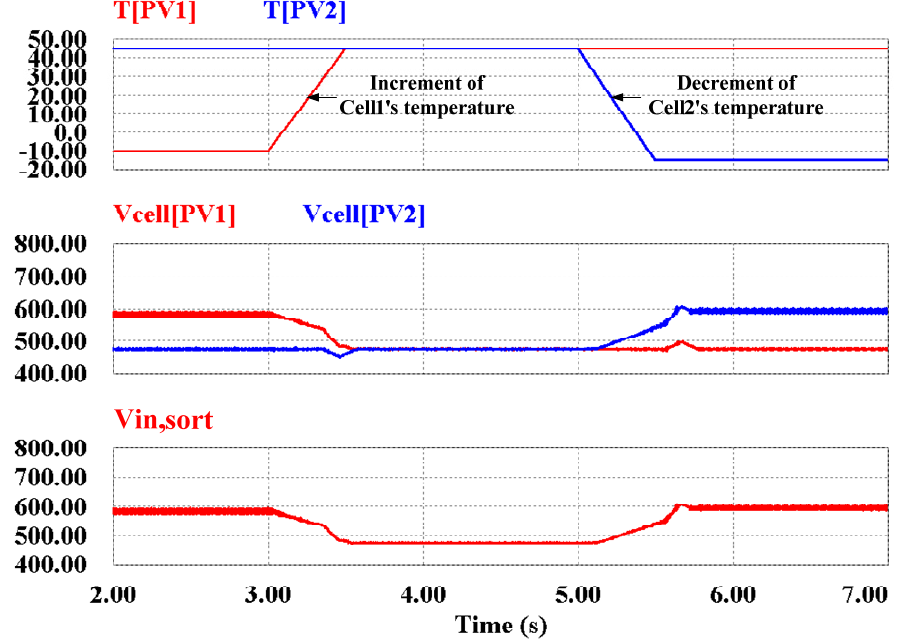
Figure 13. Simulation results for the DC-link voltage and V